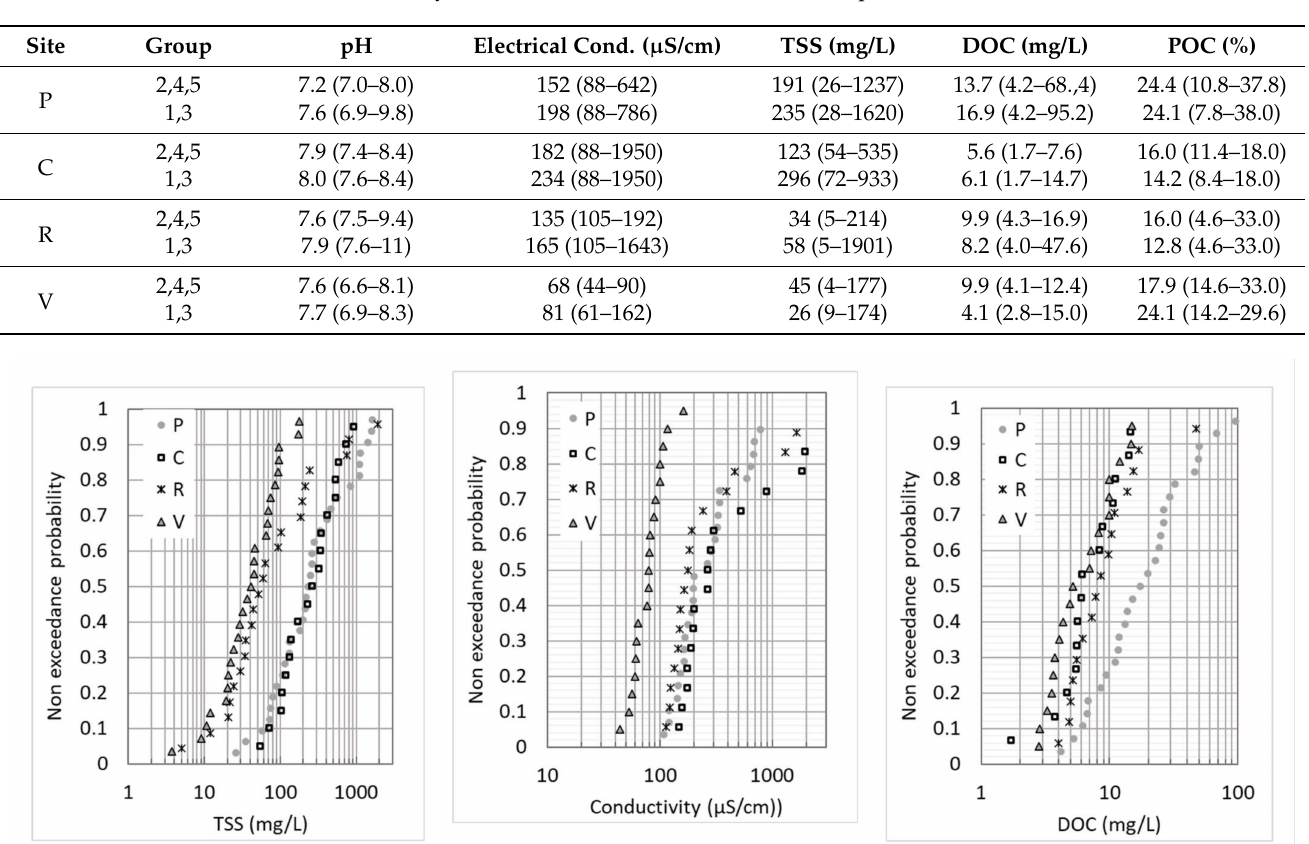
Table 4. Physicochemical characteristics of runoff samples—median (min–max) concentrations.